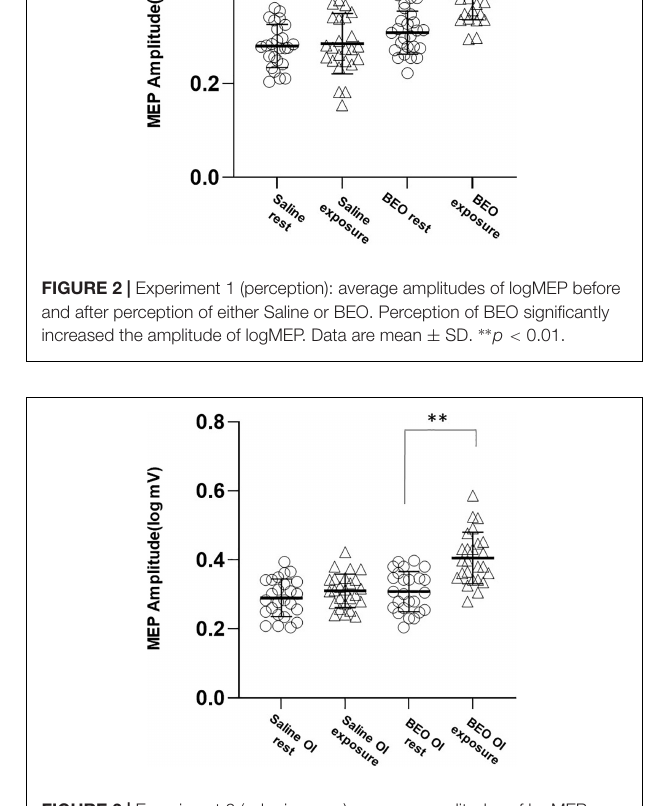
FIGURE 3 | Experiment 2 (odor imagery): average amplitudes of logMEP before and after imagery of either Saline or BEO. Imagery of BEO significantly increased the amplitude of logMEP. Data are mean ± SD. ∗∗ p <